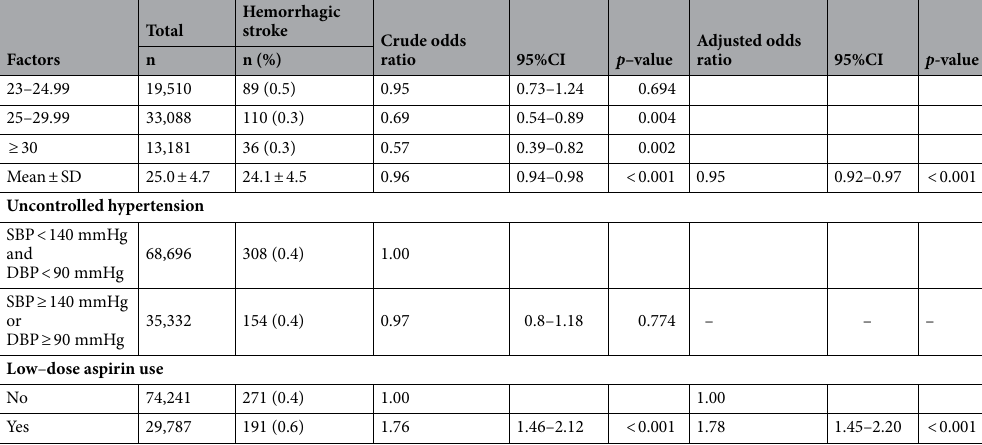
Table 4. Univariable and multivariable analyses for factors associated with hemorrhagic stroke among Thai patients with hypertension. The level of statistical significance is set at p <